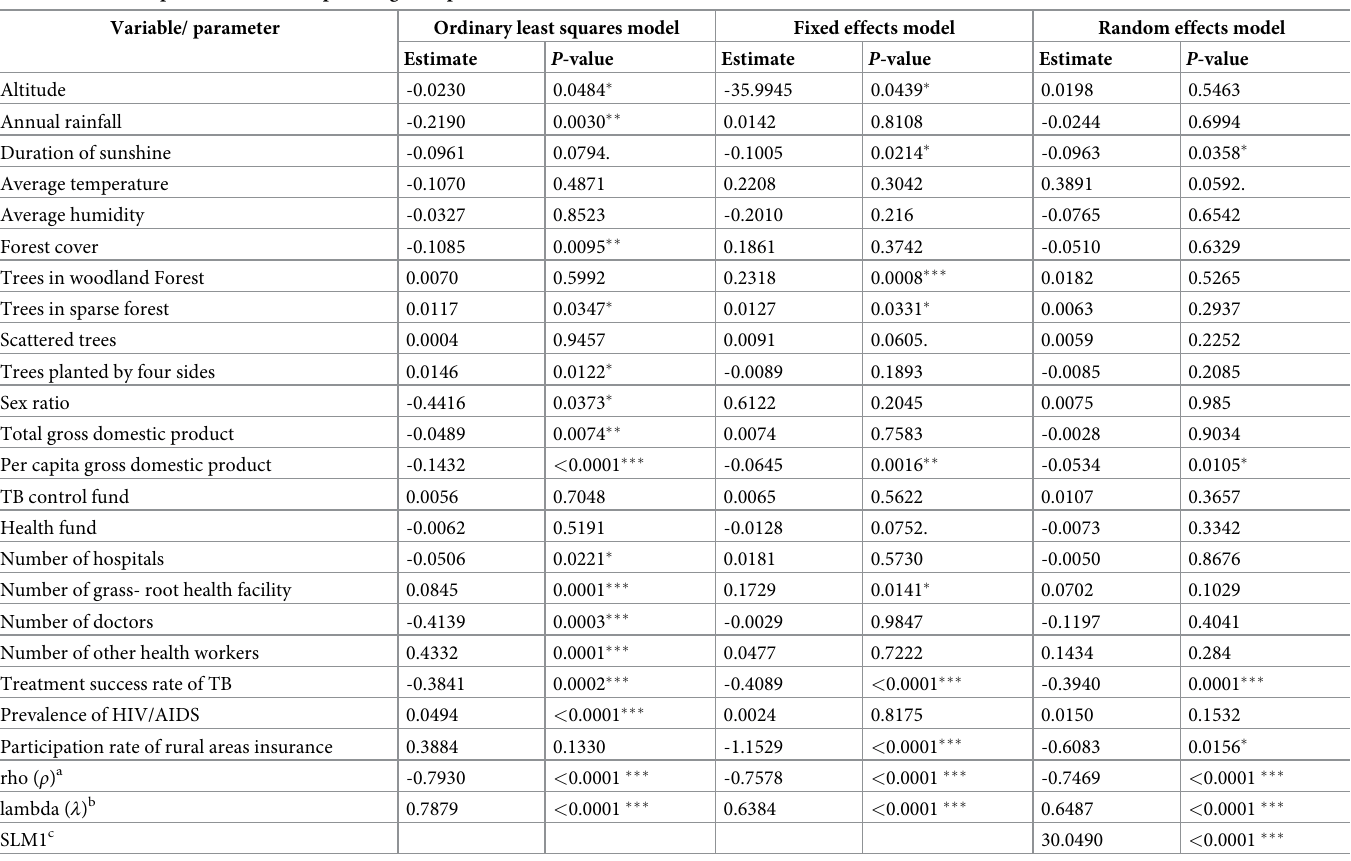
Table 5. Results of panel models with spatial lag and spatial error